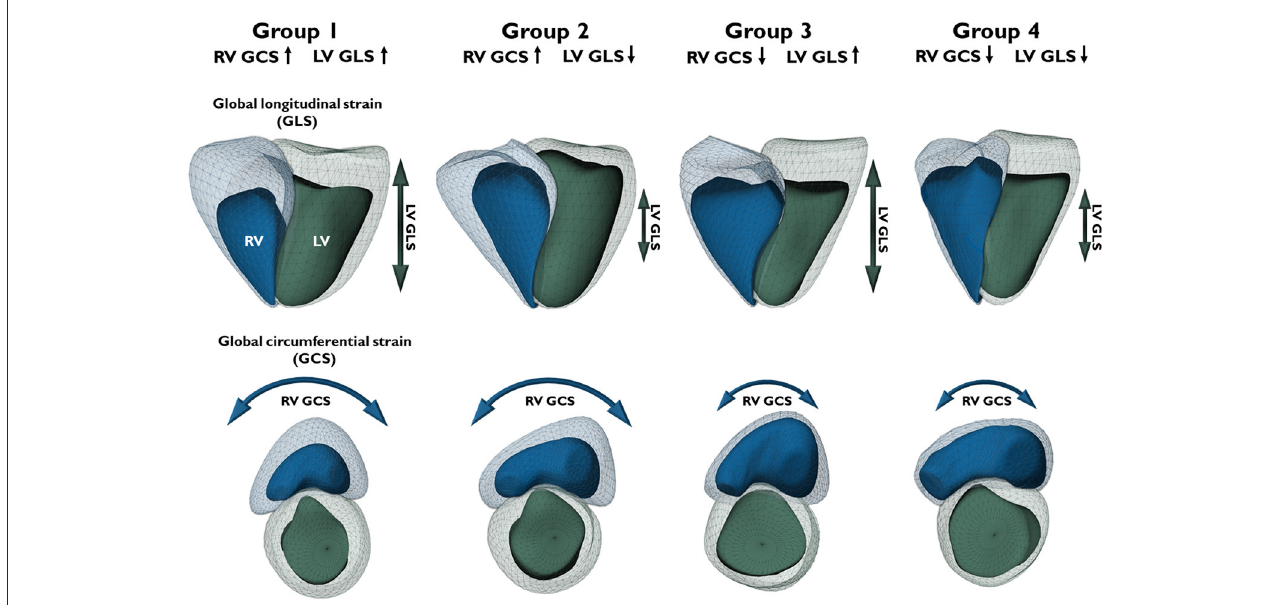
FIGURE3 Three-dimensional schematic models depict representative cases of different biventricular mechanical patterns in patients from the respective groups. The four groups were divided based on the median values of left ventricular global longitudinal strain (LV GLS, − 15.9%) and right ventricular global circumferential strain (RV GCS, − 17.9%). Upward arrows represent strain values better than the median (more negative), downward arrows represent strain values worse than the median (less negative). Light green mesh – left ventricular end-diastolic volume; dark green surface – left ventricular end-systolic volume; green arrow – LV longitudinal shortening (GLS); light blue mesh – right ventricular end-diastolic volume; dark blue surface – right ventricular end-systolic volume; blue arrow – RV circumferential shortening